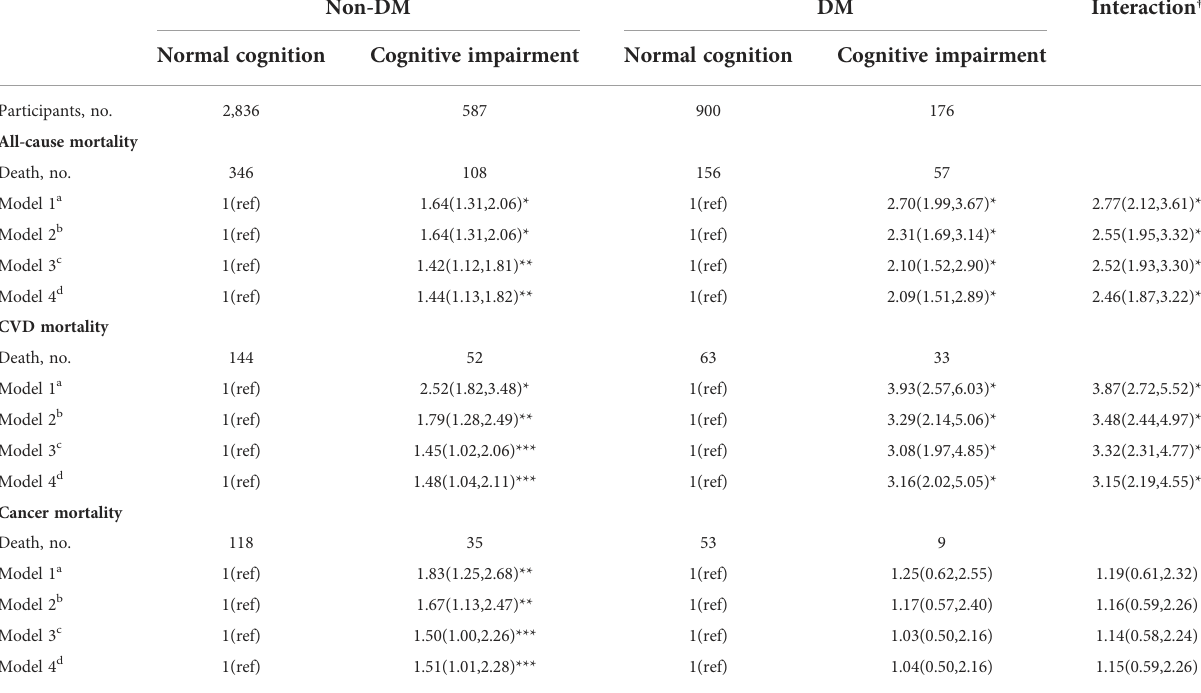
TABLE 3 Hazard ratios for the association between CI with all-cause and cause-speci fi c mortality by DM or not. Non-DM DM Interaction † Normal cognition Cognitive impairment Normal cognition Cognitive